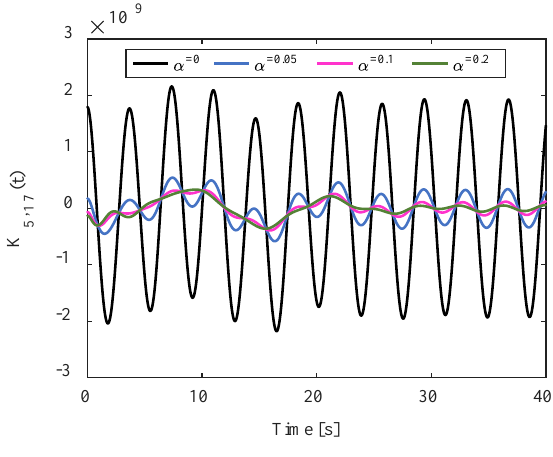
( b ) Comparison of K 3,15 (t) for different artificial damping ratios